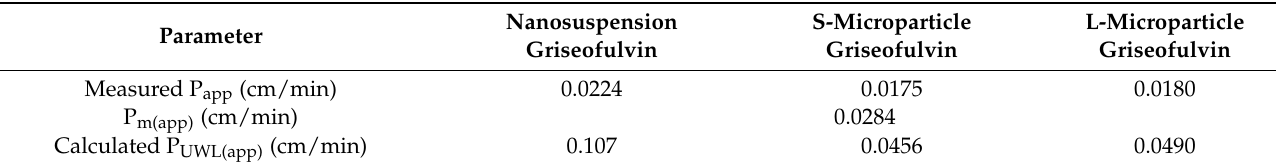
Table 2. Calculated permeability of griseofulvin.